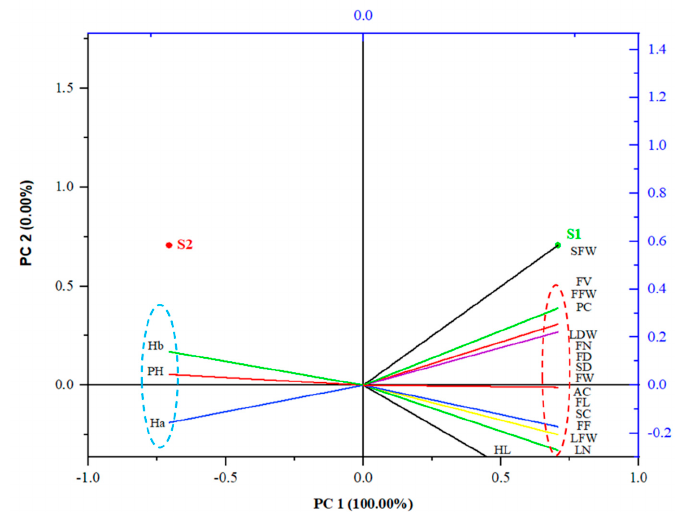
Figure 8. Principal component analysis (PCA) illustrates the variable treatment relationships be- tween the treatments of plant growth and fruit characteristics of paprika. S1 and S2 indicate that plants were treated by single shade screen and double shade screens, respectively. The lines starting from the central point of the biplots display the negative or positive associations of the different variables, and their proximity specifies the degree of correlation with specific treatment. PH, plant height; LN, number of leaves; LFW, leaf fresh weight; LDW, leaf dry weight; SD, stem diameter; SFW, shoot fresh weight; FN, number of fruits; FFW, fruit fresh weight; FD, fruit diameter; FL, fruit length; FW, fruit width; PC, pericarp thickness; FF, fruit firmness; FV, fruit volume; SC, sugar con- tent; AC, acidity; H-L, Hunter L; H-a, Hunter a; H-b, Hunter b.